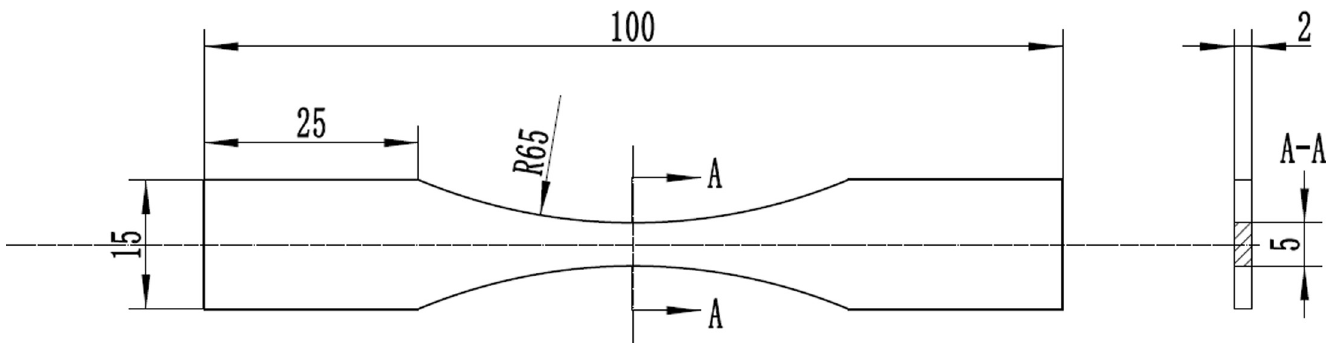
Fig 1. Specimen dimension.